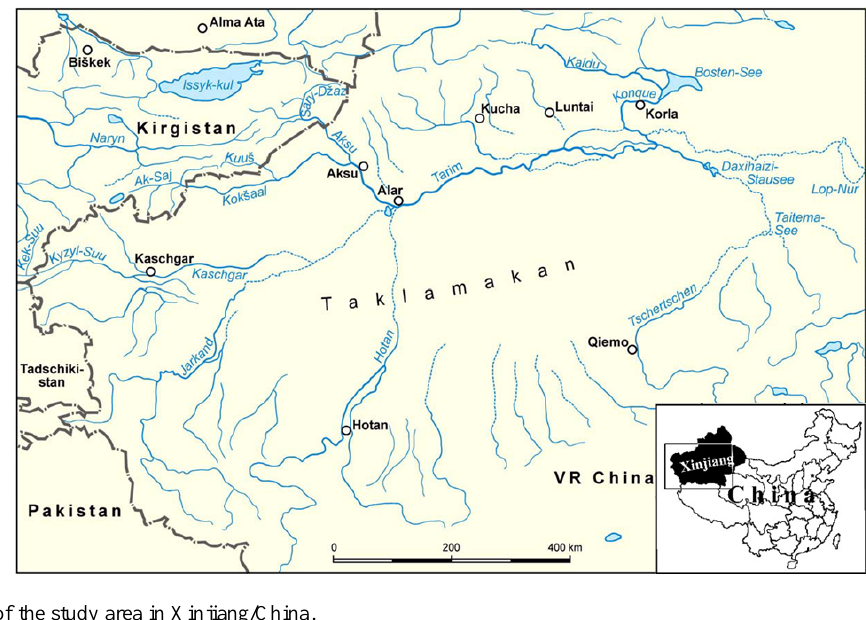
Figure 1. Location of the study area in Xinjiang/China.